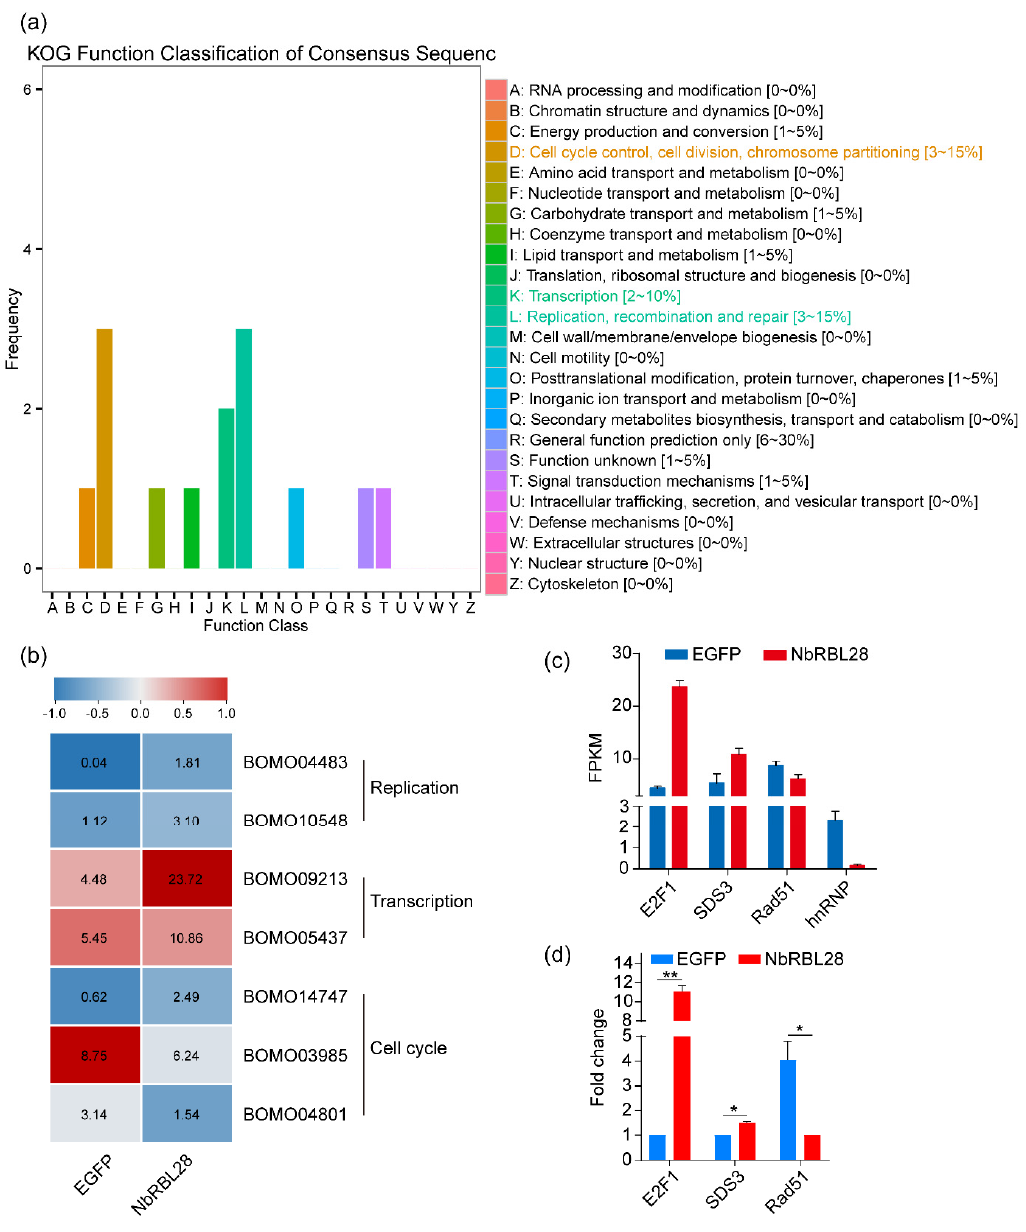
Figure 8. NbRBL28 alters the host cell transcriptome. ( a ) KOG function classification of the differentially expressed genes when comparing RBL28 versus EGFP-transfected cells. ( b ) Heatmap representation of the genes identified by KEGG analysis of the different data sets. ( c , d ) RT-qPCR analysis for differently expressed genes were coincidental with those of RNA-Seq. *, p < 0.05; **, p < 0.01.